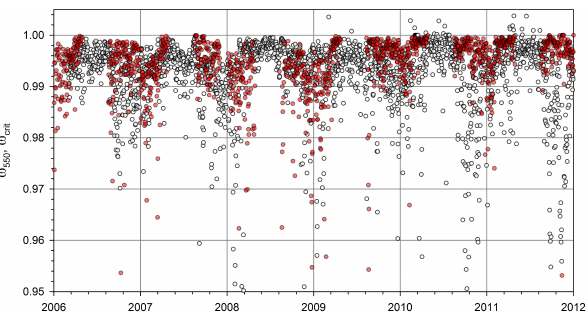
Fig. 7. Time series of the measured single scattering albedo at 550nm, ω 550 (black circles) along with the calculated critical sin- gle scattering albedo ω crit (red circles). Note that ω crit values were not available between end of April and early August of each year, because then solar radiation was below 10Wm − 2 and R s could not be reliably determined.